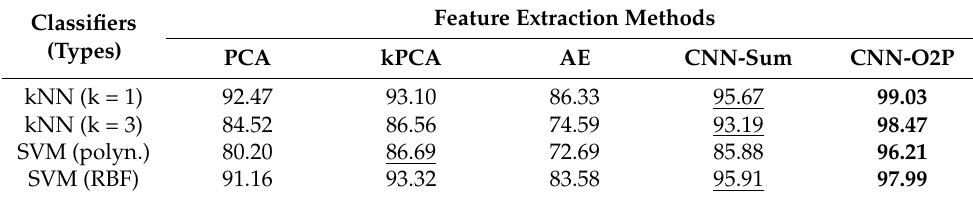
Table 2. Classification accuracy rates (mean)